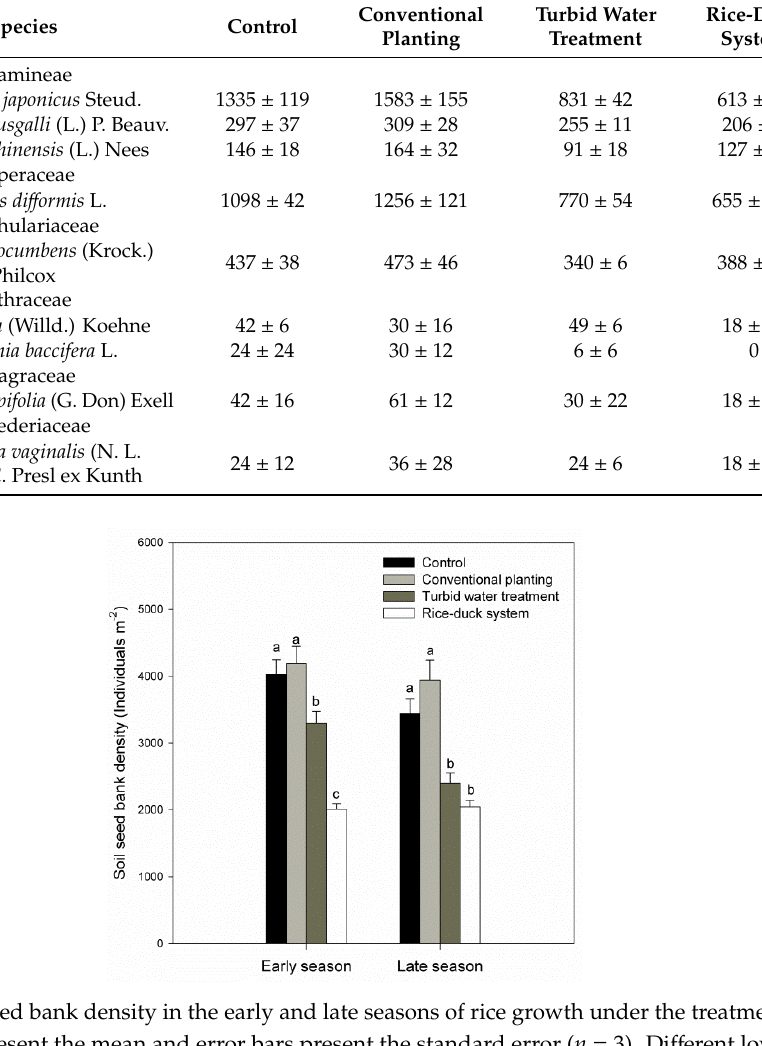
soil layer contributed to most of soil seed